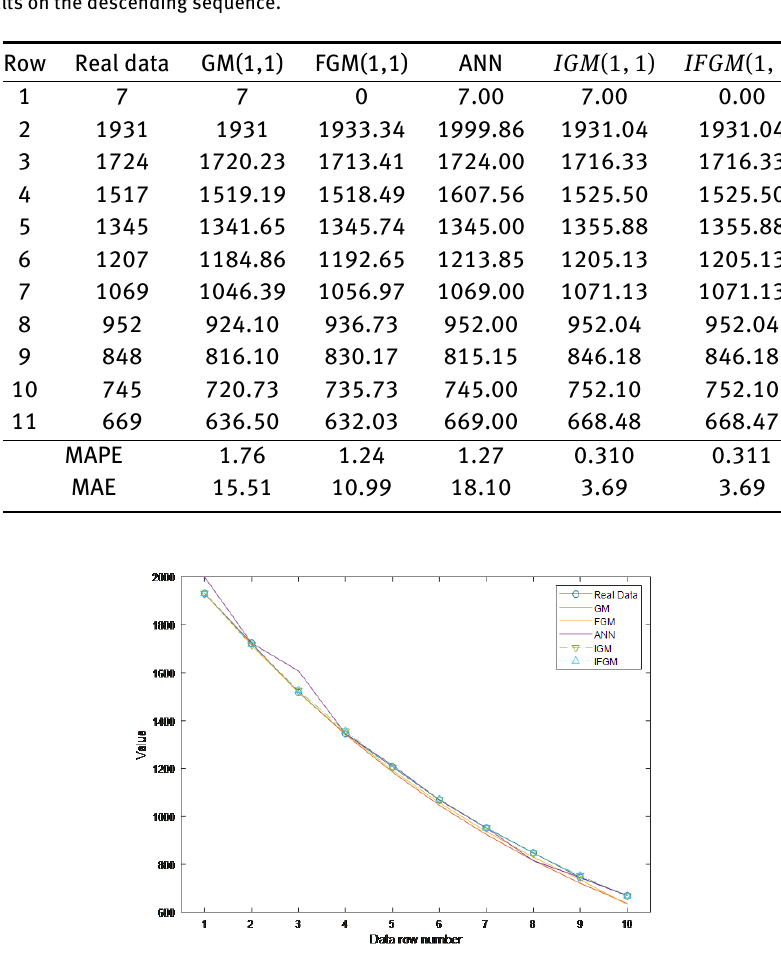
Table 2: The results on the descending sequence.